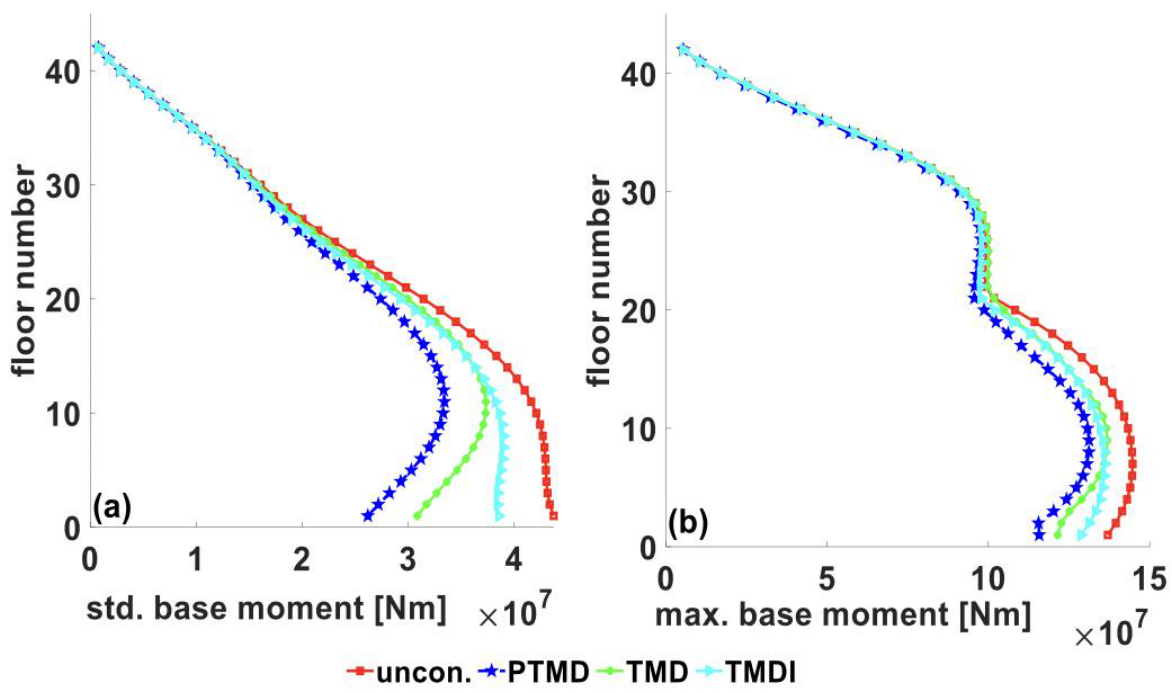
Figure 23. The base moment at each floor: ( a ) STD moment, ( b ) maximum moment.